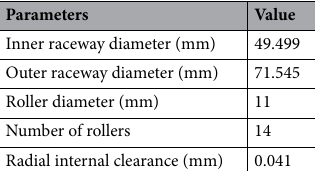
Table 2. Main parameters of cylindrical roller